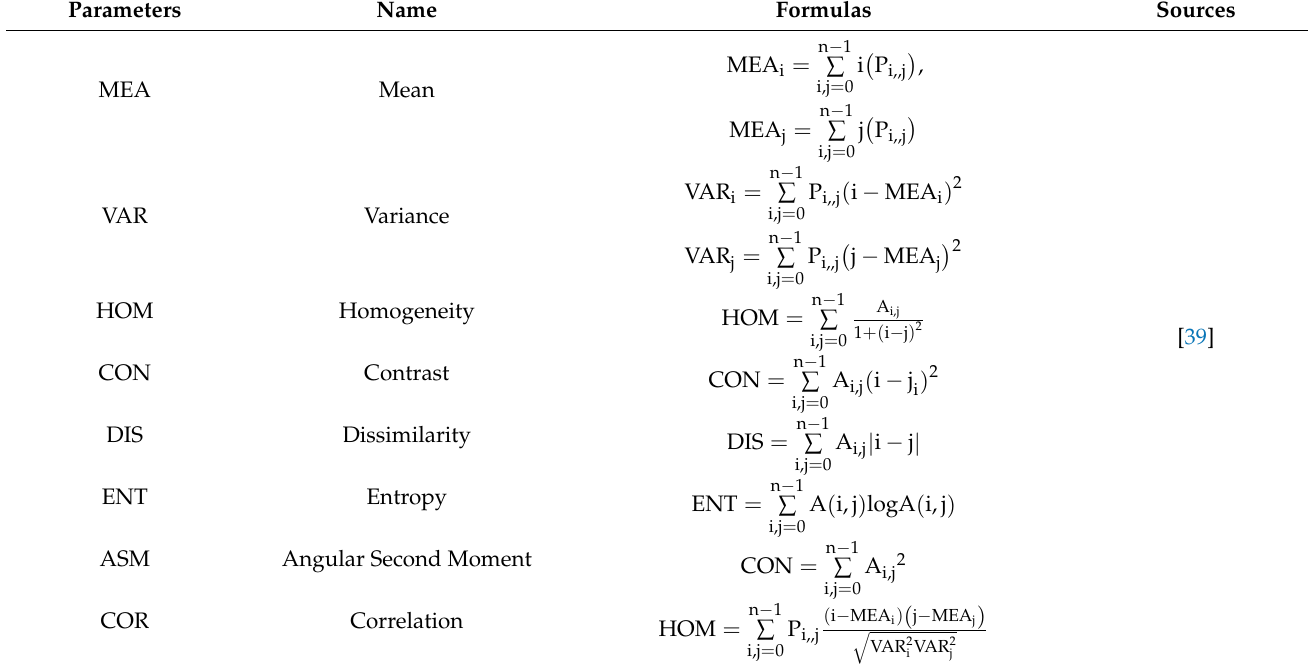
Table 3. Textural parameters related to LAI of UAV RGB